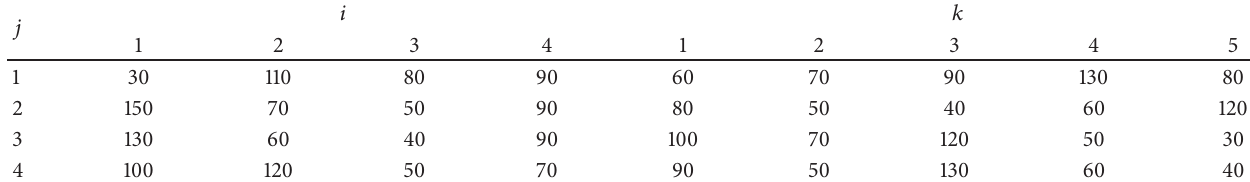
Table 4: Parameters related to distances of different network nodes.